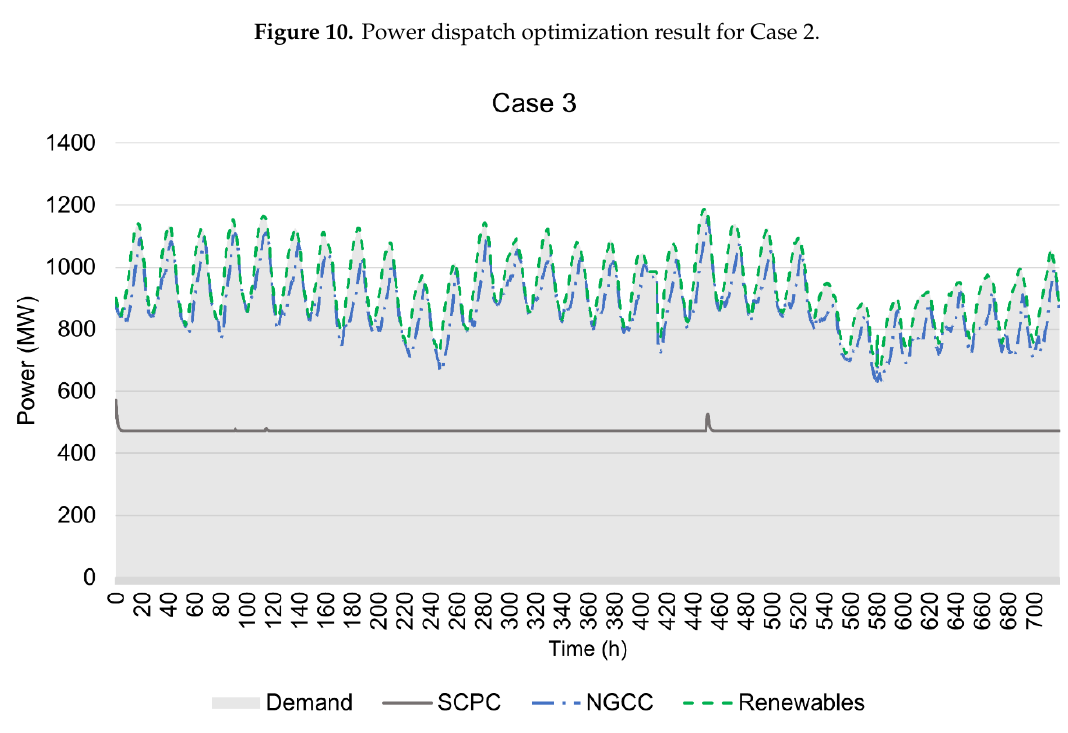
Mathematics 2019 , 7 , x FOR PEER REVIEW Figure 10. Power dispatch optimization result for Case 2. Figure 10. Power dispatch optimization result for Case 2.